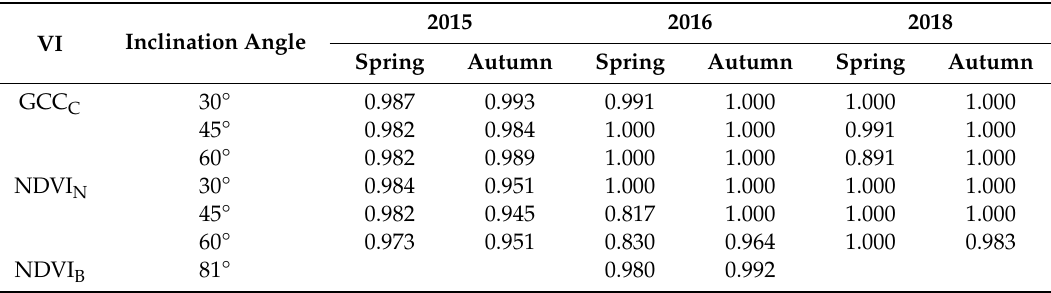
VI: vegetation index; GCC C : green chromatic coordinate from camera; NDVI N : narrowband normalized difference vegetation index from spectroradiometer; NDVI B : broadband normalized difference vegetation index from routine radiometer. The 15° is the reference for GCC C and NDVI N , and the 90° is the reference for NDVI B .